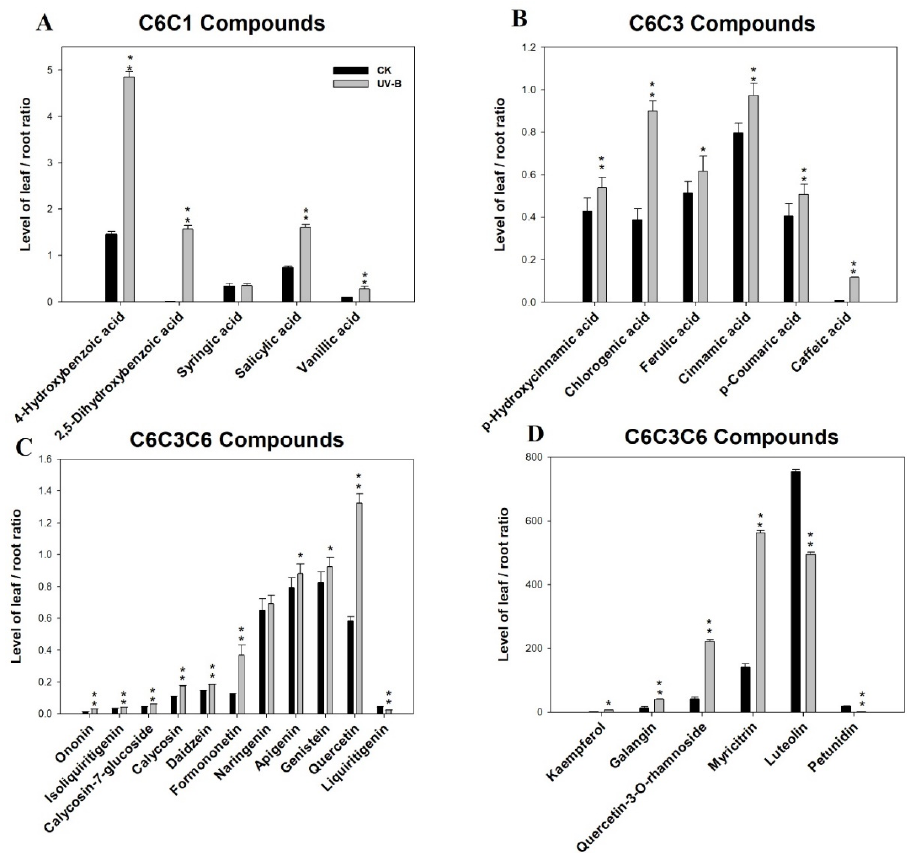
Figure 4. Distribution of phenolics that have various carbon skeletons in above- and belowground tissues under UV-B radiation. The ordinate is set to the ratio of compound contents in leaves and roots. ( A ) Phenolics with C6C1 carbon skeletons; ( B ) phenolics with C6C3 carbon skeletons; ( C ) and ( D ) phenolics with C6C3C6 carbon skeletons.